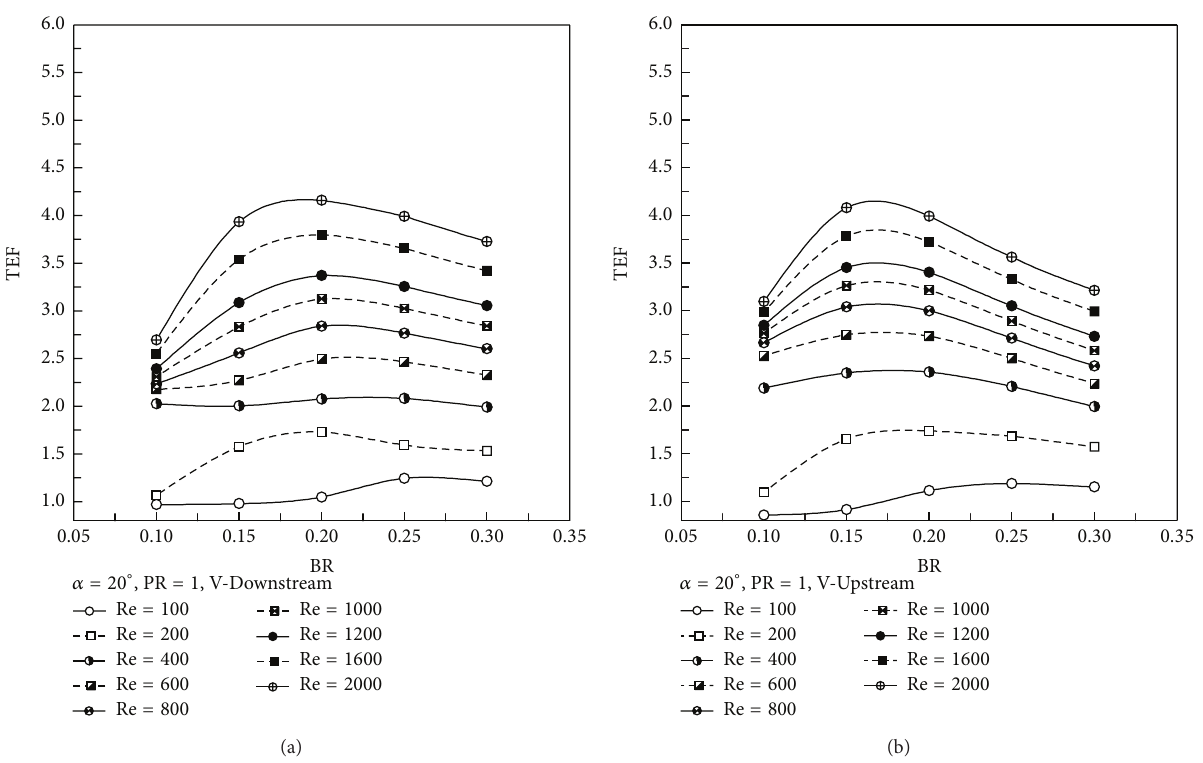
Figure 12: TEF versus BRs at various Reynolds number values for (a) V-Downstream and (b)